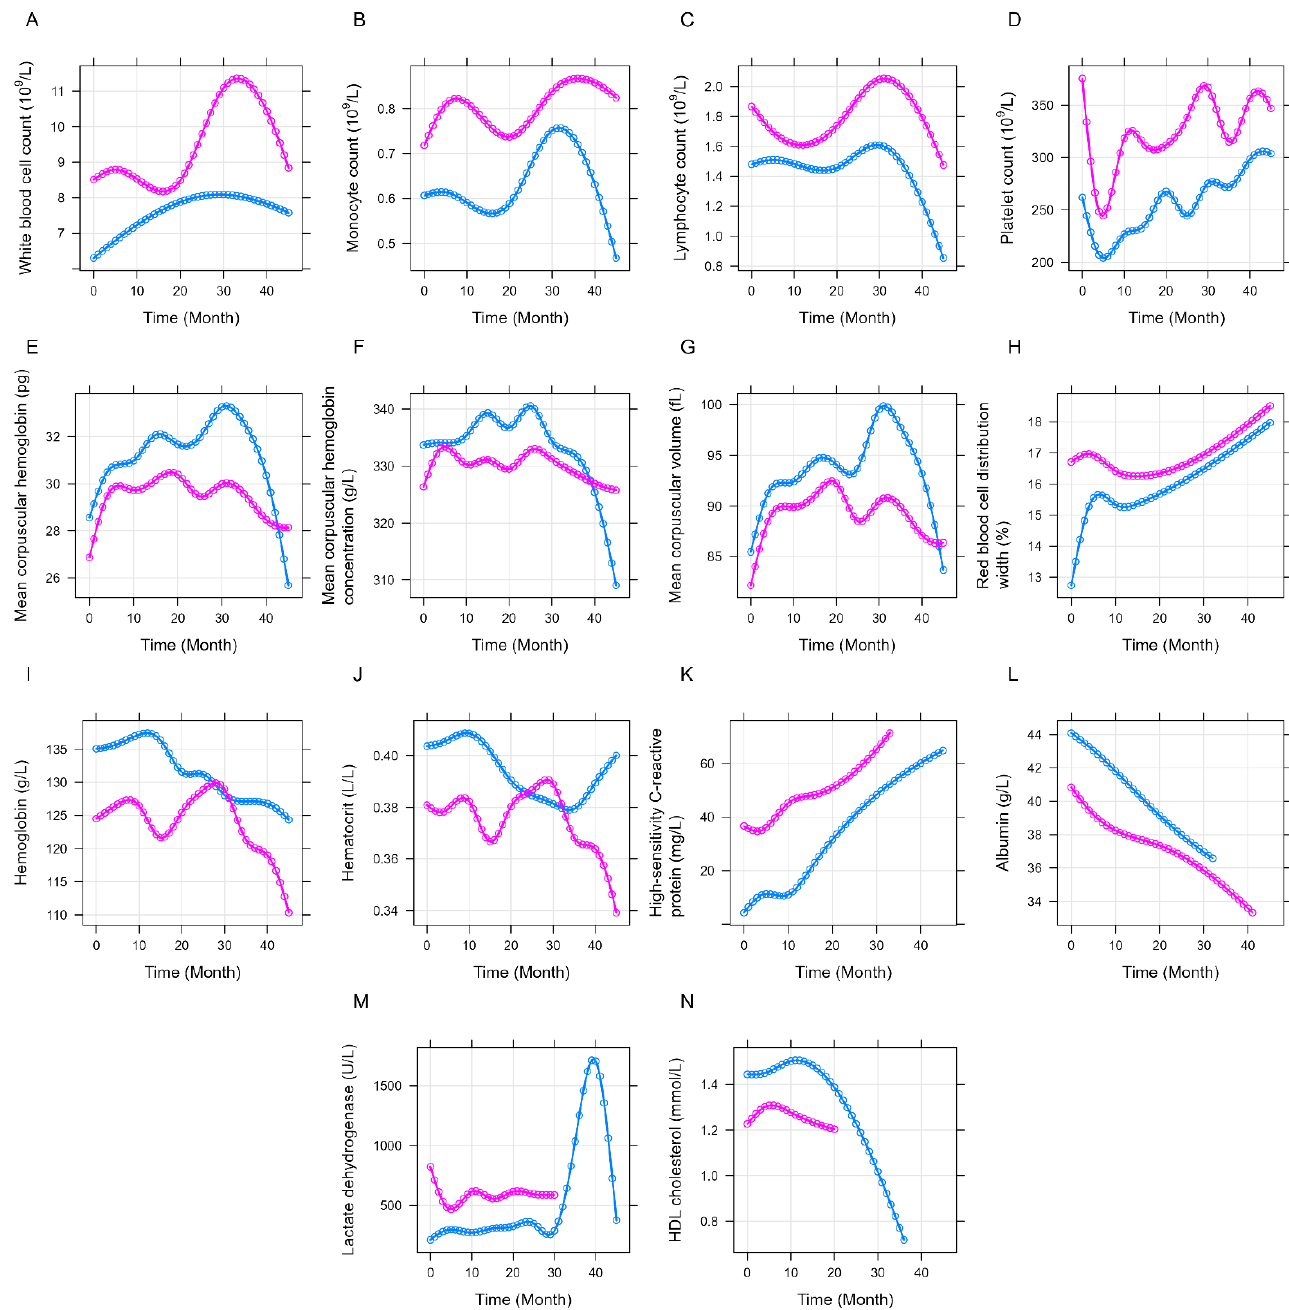
Figure 5. Longitudinal changes in the various laboratory measurements throughout the study within the PD-L1 < 13 ng/mL (blue) and PD-L1 > 13 ng/mL (magenta) groups. Significantly higher ( A ) white blood cell, ( B ) monocyte, ( C ) lymphocyte, and ( D ) platelet counts, as well as higher ( H ) red blood cell distribution width, ( K ) high-sensitivity C-reactive protein levels, and ( M ) lactate dehydrogenase levels were found in the PD-L1 > 13 ng/mL group. Higher ( E ) mean corpuscular hemoglobin levels, ( F ) mean corpuscular hemoglobin concentration, ( G ) mean corpuscular volume, ( I ) hemoglobin levels, ( J ) hematocrit levels ( L ) serum albumin levels, and ( N ) high-density lipoprotein (HDL) cholesterol levels were characteristic for the PD-L1 < 13 ng/mL group. PD-L1: programmed death-ligand 1.